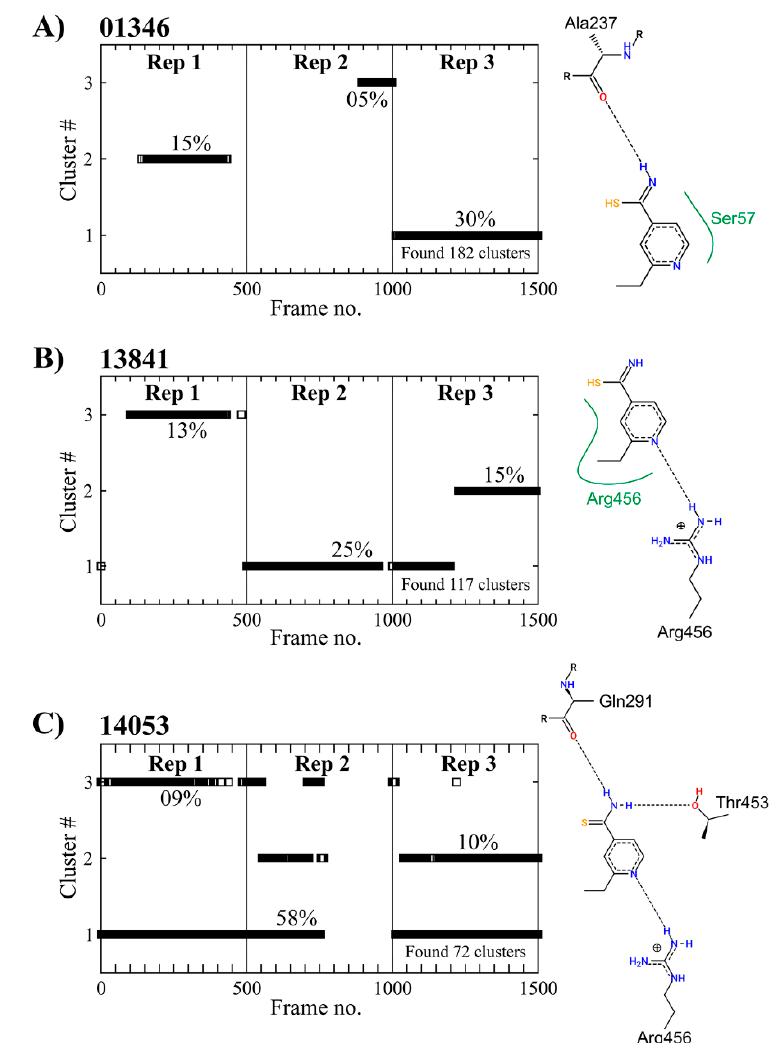
Figure 5. ETH clustering analysis from the MD simulations for systems ( a ) 01346, ( b ) 13841 and ( c ) 14053. The fractional contribution of the first three clusters is shown in each graph. 2D representation of Protein-ETH interaction of the most representative structures resulting from clustering analysis is displayed next to each plot (Poseview server). Black dashed lines and full green lines show hydrogen bonds and hydrophobic interactions, respectively.